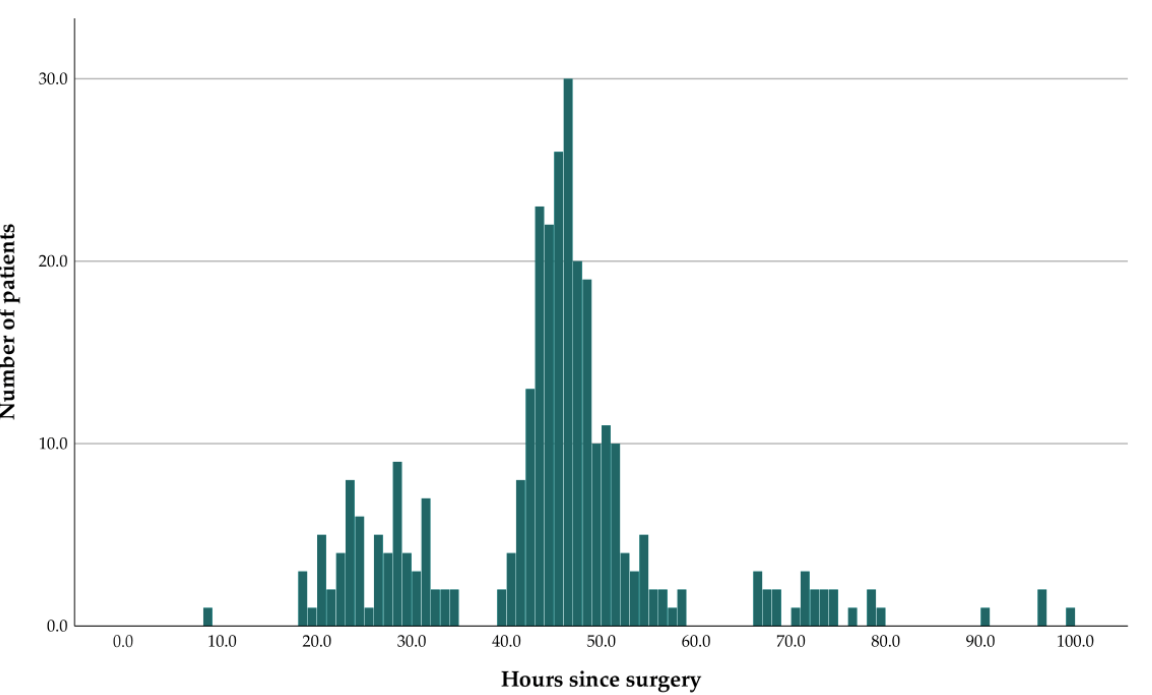
Figure 3. Histogram showing the time distribution of the early postoperative MRI for all patients. The x-axis represents the time from surgery to early postoperative MRI and the y-axis represents the number of patients for each hour.